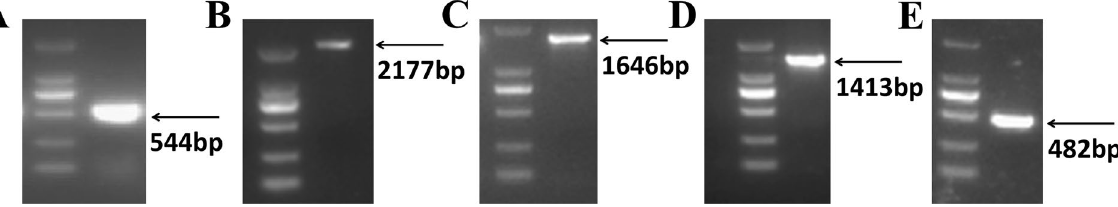
Figure 1. PCR amplification of the open reading frame (ORF) and different promoter segments of GPIHBP1 . The DNA markers were DL2000:2000bp, 1000 bp, 750 bp, 500 bp, 250 bp, 100 bp. ( A ) Band of the ORF (size = 544 bp). ( B ) Band of the promoter fragment (size = 2177 bp) that contains all four SNPs. ( C ) Band of the promoter fragment (size = 1646bp) that contains the first three SNPs. ( D ) Band of the promoter fragment (size = 1413 bp) that contains the first two SNPs. ( E ) Band of the promoter fragment (size = 482 bp) that contains only the first